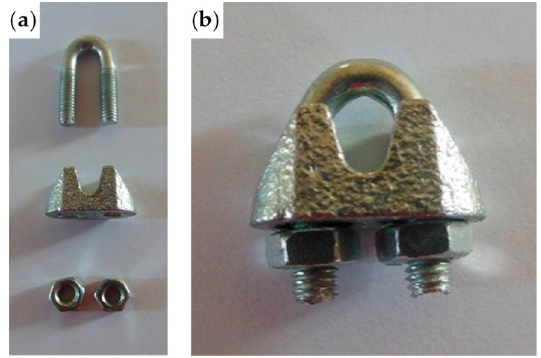
Figure 24. The clips of the experimentation: ( a ) constituent parts and ( b ) a clip after assembly.